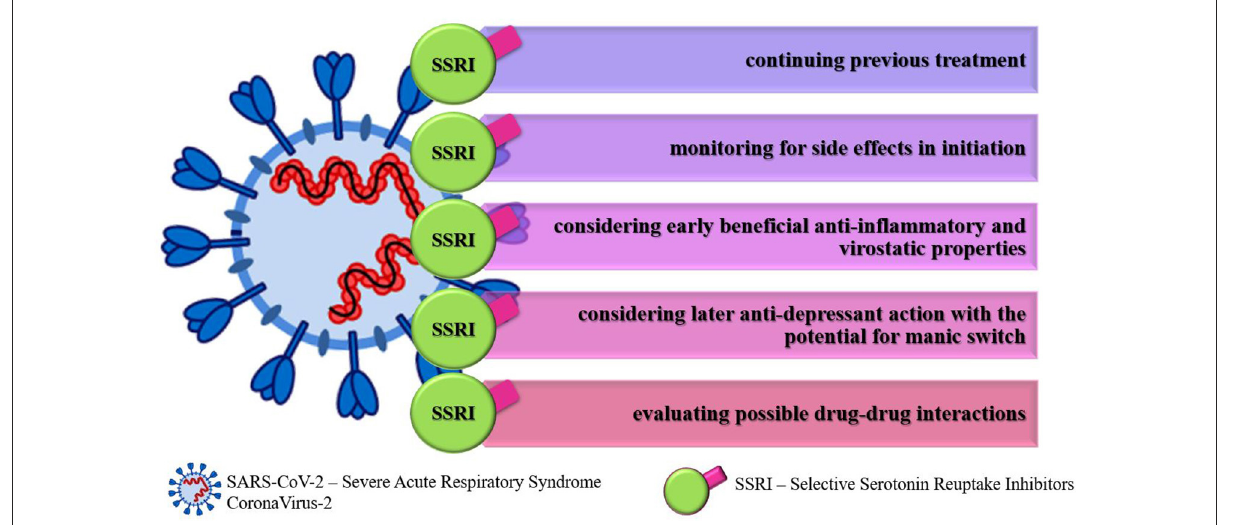
FIGURE1 Recommendations for selective serotonin reuptake inhibitors usage in COVID-19